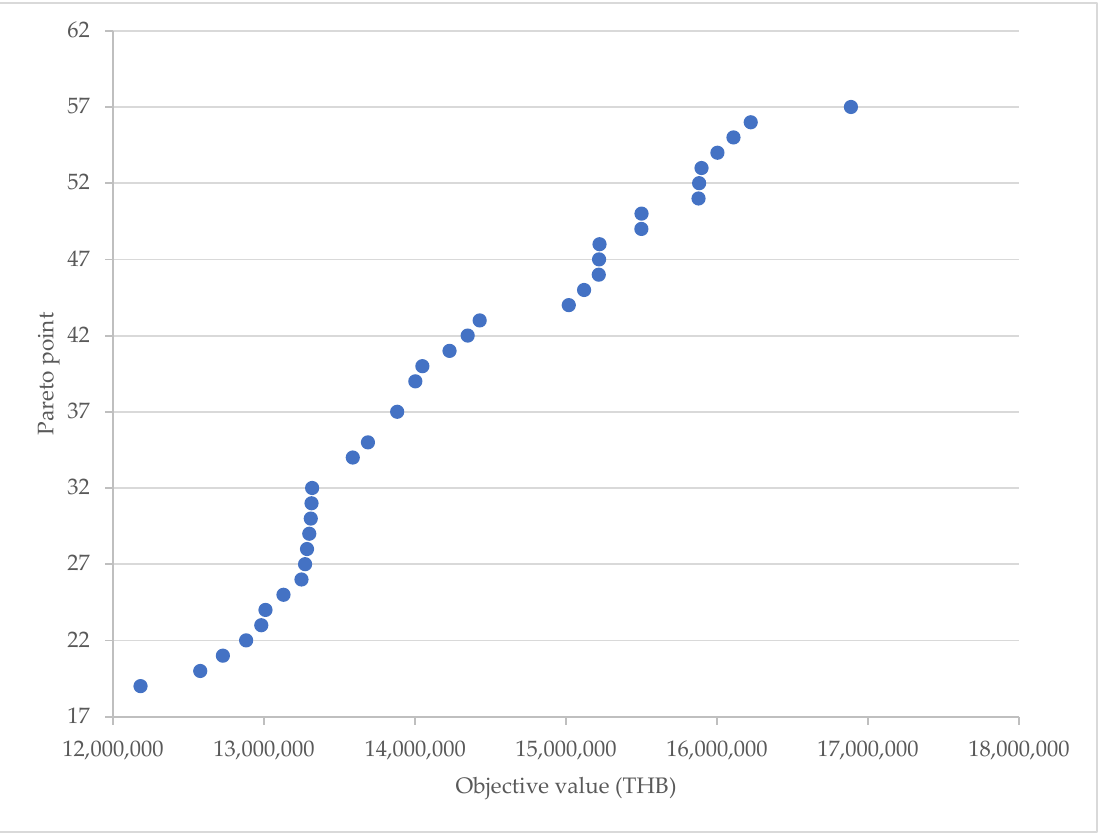
Figure 6. Pareto front of AMIS.